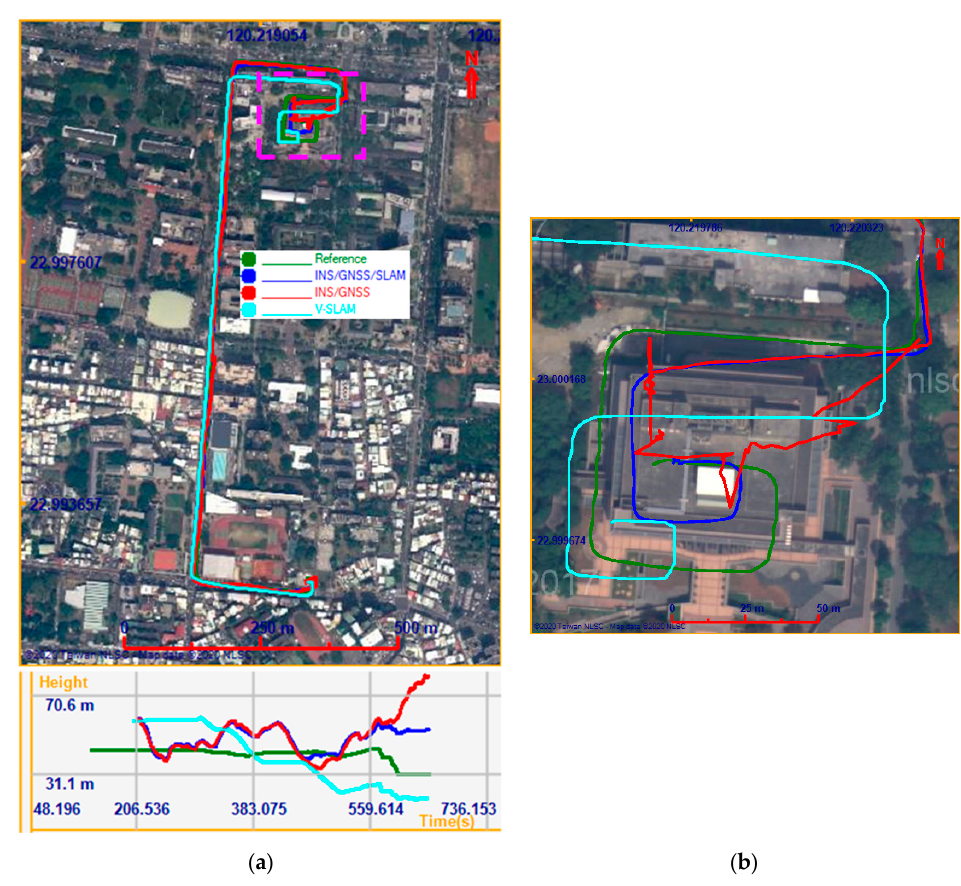
Figure 15. Trajectories of the various solutions in the second test ( a ); Carpark detail ( b ).